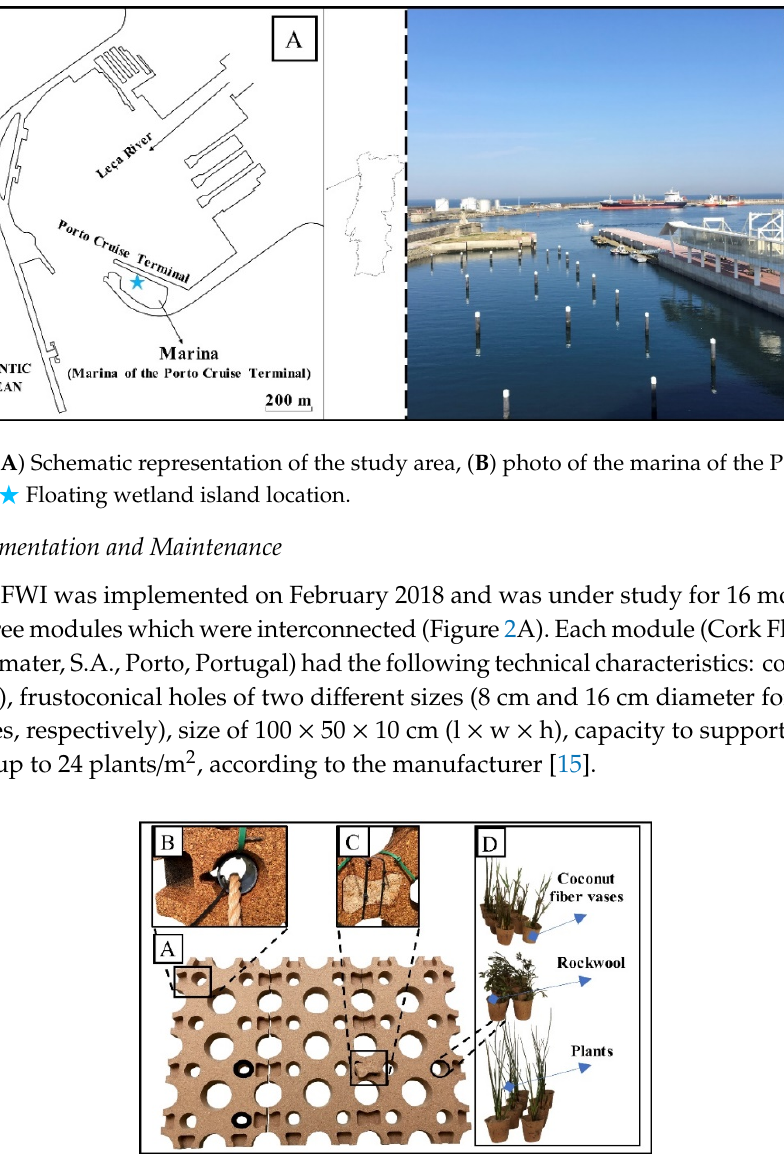
Figure 1. (A) Schematic representation of the study area, (B) photo of the marina of the Porto Cruise Terminal. Floating wetland island location.